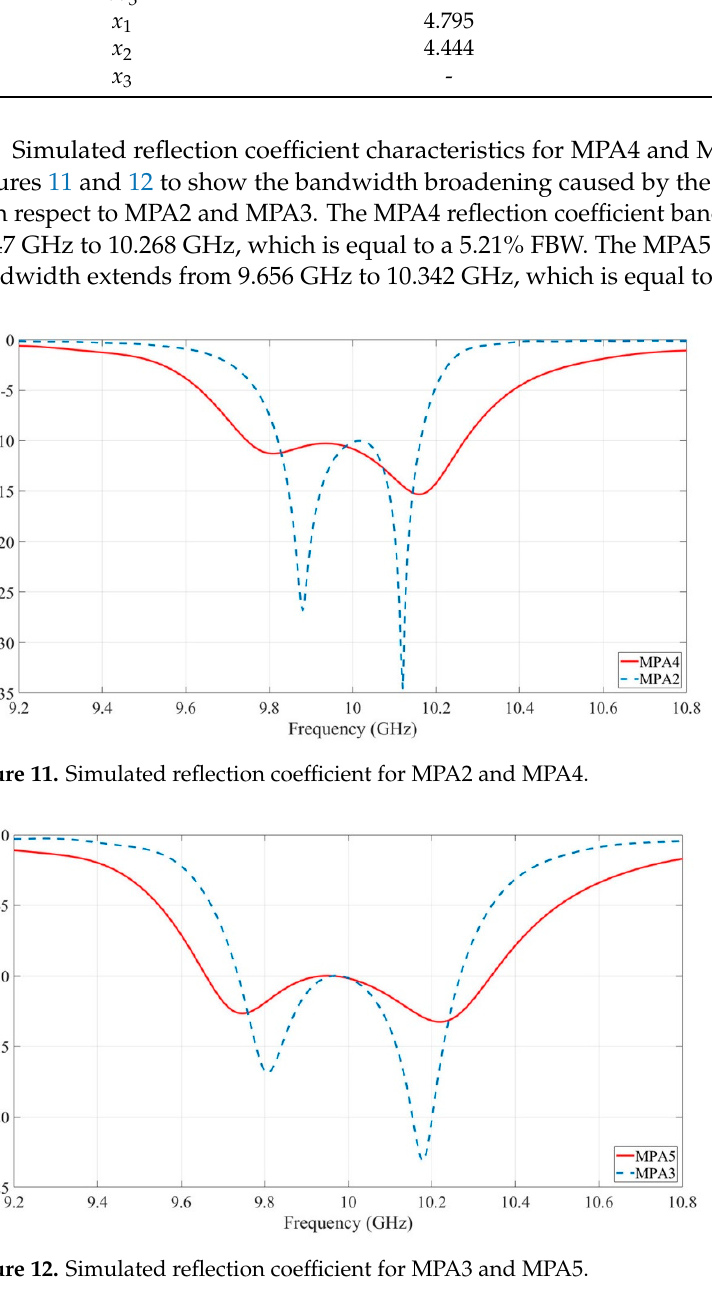
Table 3. MPA4 and MPA5 geometrical parameters.